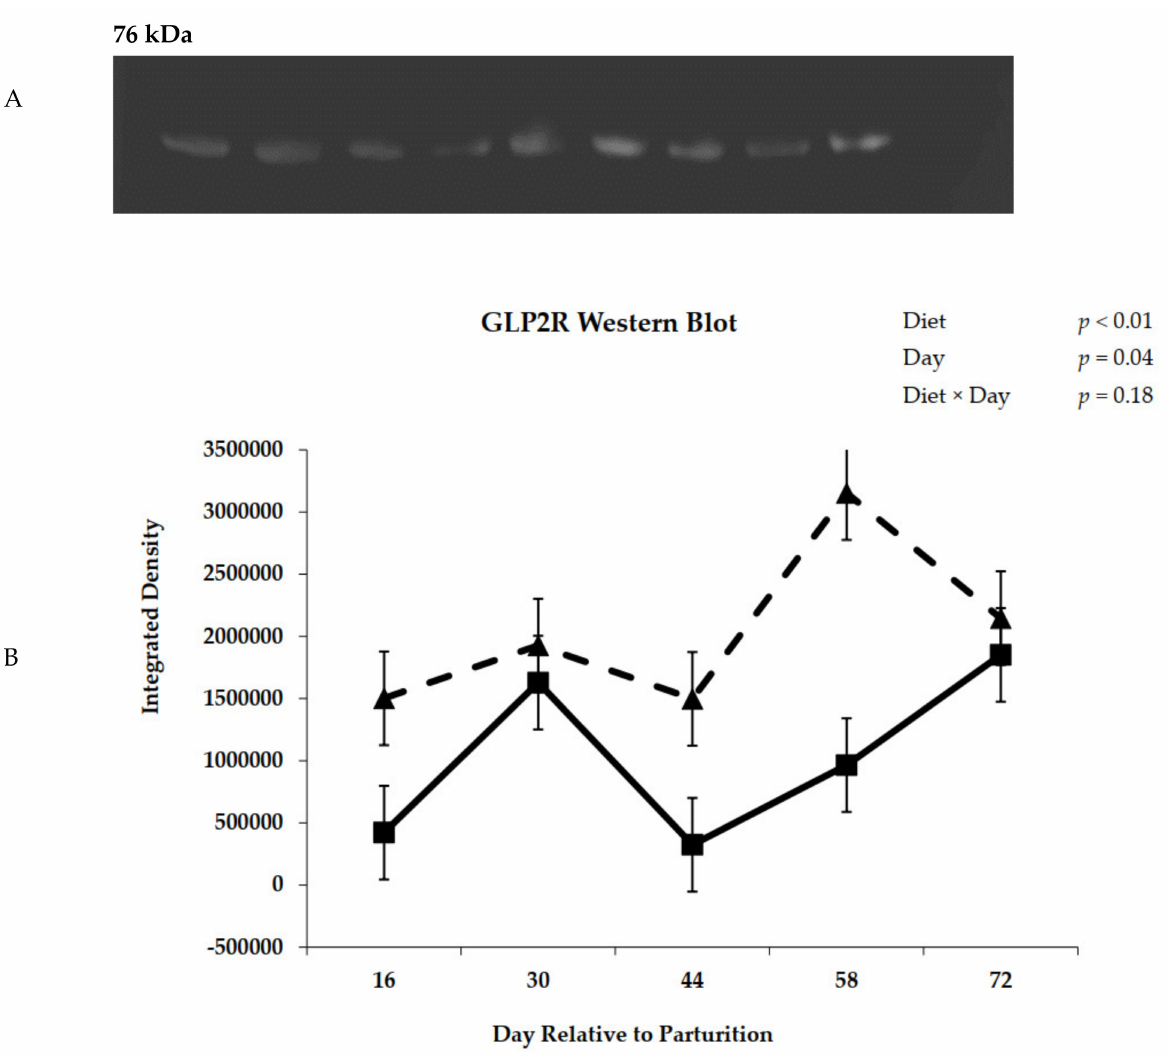
Figure 9. Representative Western blot analysis of glucagon-like peptide-2 receptor from rumen epithelium during postpar- tum period (Panel A , Figure S2). Glucagon-like peptide-2 receptor density in rumen epithelial tissue from cows fed control (triangles) or molasses-containing (boxes) diets during the postpartum period (Diet, p < 0.01; Day, p = 0.04; Diet × Day, p = 0.18; error bars = pooled standard error of the mean, Experiment 2, n = 3; Panel B